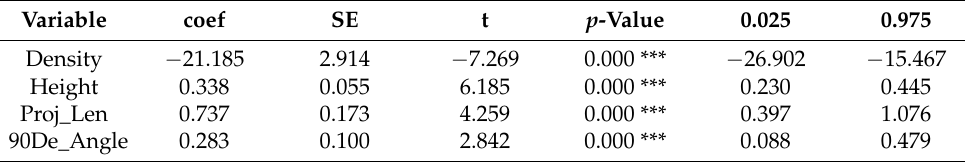
Table 7. OLS correlation of the selected variables.